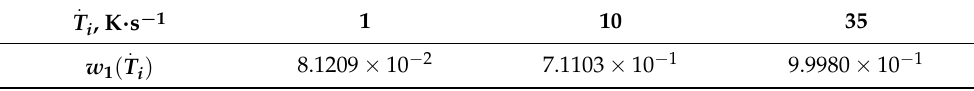
Table 2. Weight coefficients of the mechanisms of crystallization of the PEEK